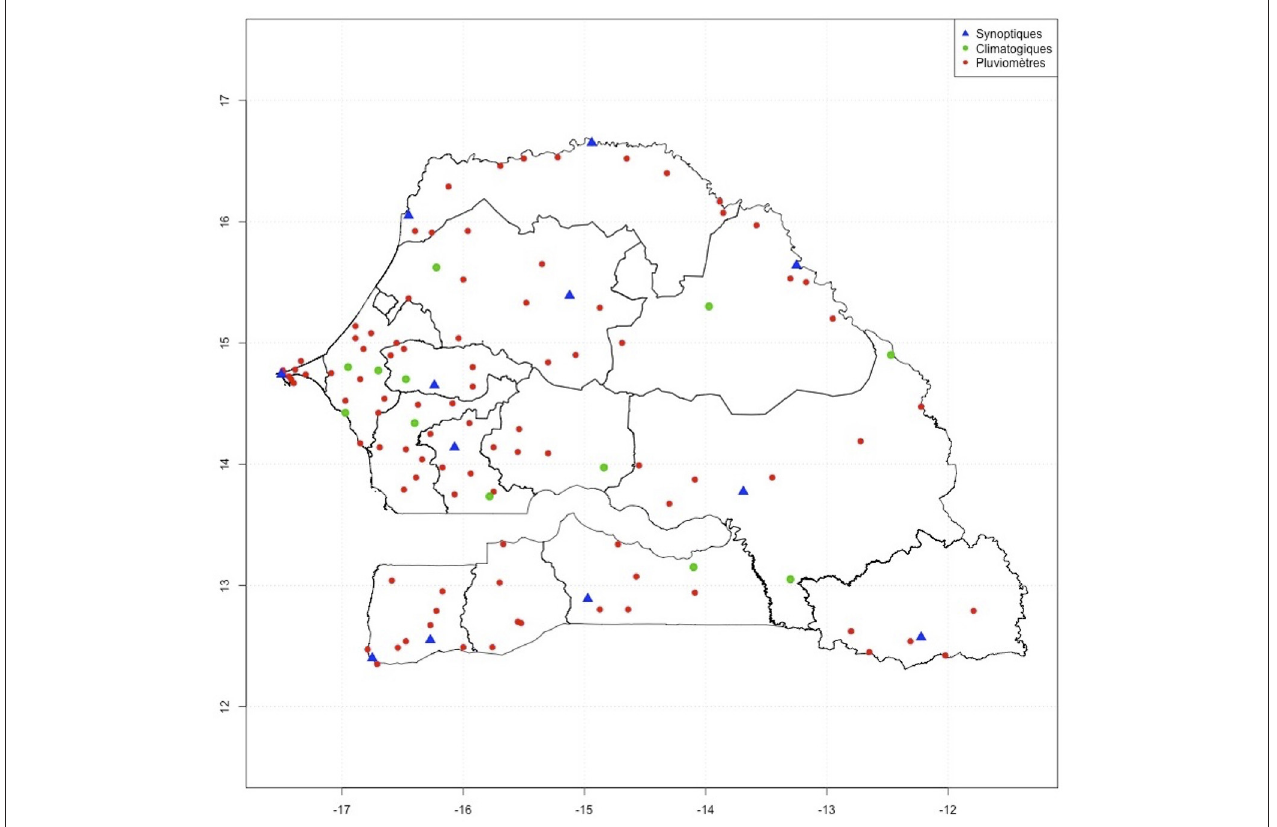
FIGURE 6 | Different classes of meteorological stations over Senegal: synoptic (blue), climate (green), and raingauge only (red).